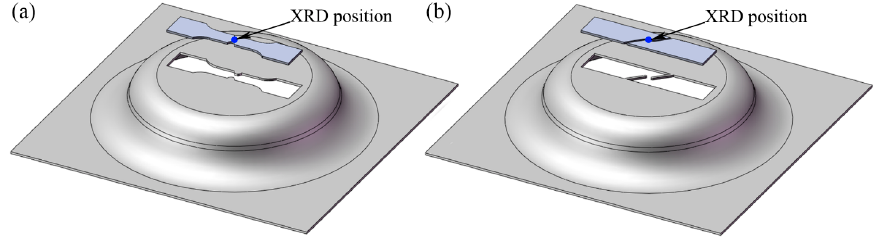
Figure 22. Specimens for the second-round deformation: ( a ) mini notched specimen; ( b ) mini pure shear specimen.